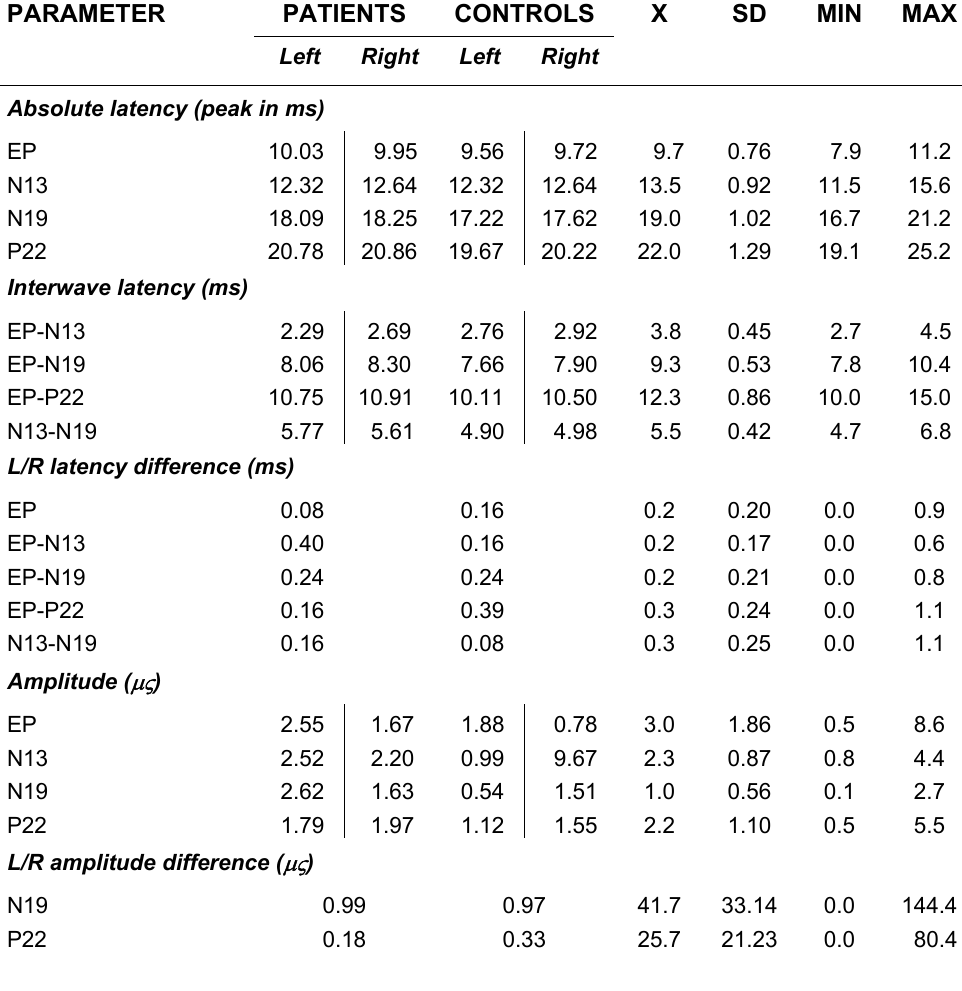
Mean Parametric Median Nerve Somatosensory Measurements in Both the Patients and the Healthy